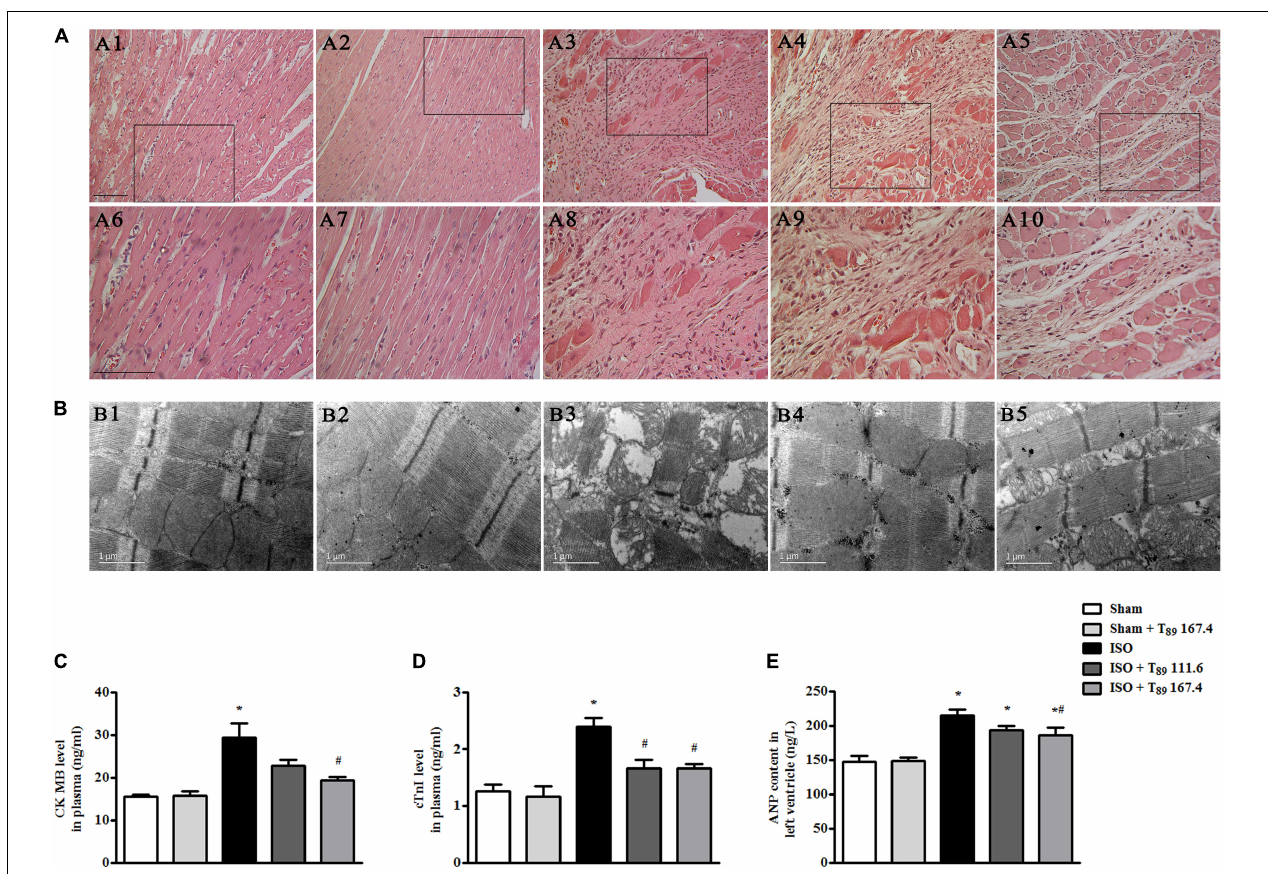
FIGURE 2 | Effect of T 89 on myocardial histology, ultrastructure, and myocardial injury after ISO. (A) Representative HE-stained images in Sham (A1, A6), Sham + T 89 167.4 group (A2, A7), ISO (A3, A8), ISO + T 89 111.6 (A4, A9), and ISO + T 89 167.4 (A5, A10). The upper panel was acquired at × 10 magnification of objective, and the lower panel was captured at × 20 magnification of objective. Bar = 100 µ m. (B) Representative images of myocardial ultrastructure in Sham (B1), Sham + T 89 167.4 group (B2), ISO (B3), ISO + T 89 111.6 (B4), and ISO + T 89 167.4 (B5). (C – E) The alteration of CK MB ( C , n = 6) and cTnI ( D , n = 6) content in plasma, and ANP content ( E , n = 12) in the left ventricle. * P < 0.05 vs. Sham group, # P < 0.05 vs. ISO